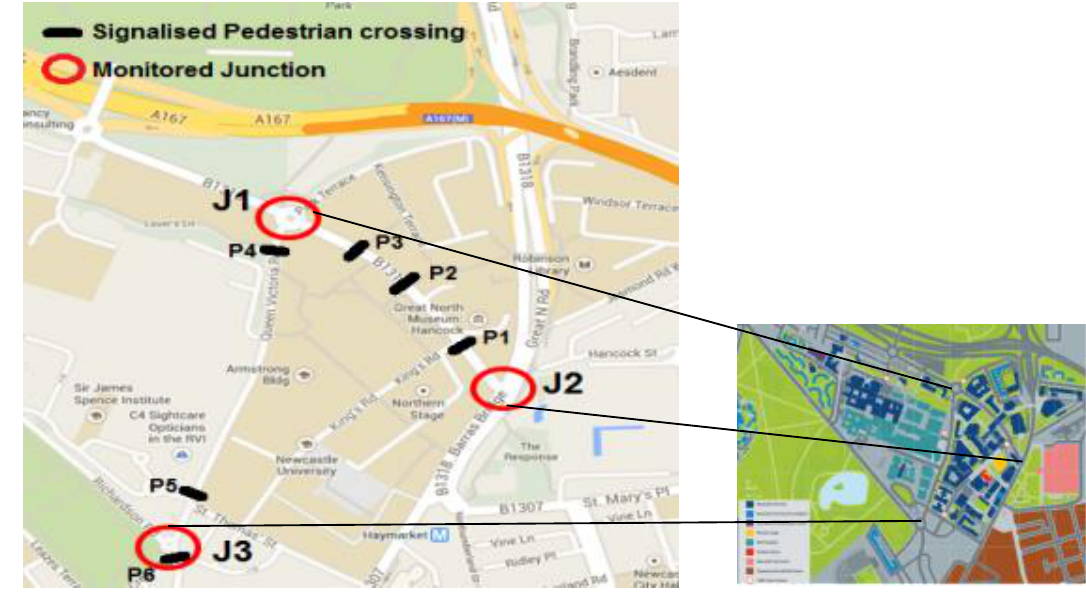
Figure 5. Junctions and pedestrian crossings where network traffic survey was performed The traffic data collected were aggregated at 5 and 15 minutes resolution, taking into account four different vehicle categories: car, LGV, HGV and bus. For the micro-simulation model setup the 15 minutes resolution was considered adequate to evaluate the network performance and quantify the impact; however for future investigation, it would be possible to increase the resolution to 5 minutes.